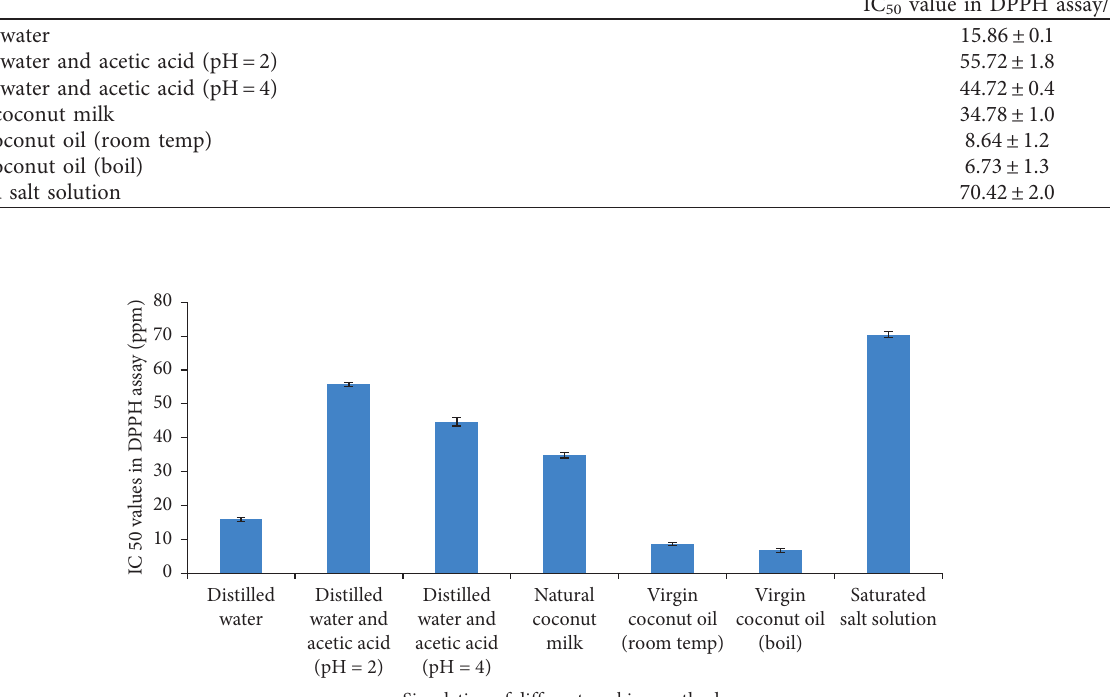
Table 1: IC 50 values of differently processed extracts of G. quaesita simulating cooking conditions in DPPH assay. Extract IC 50 value in DPPH assay/ppm Distilled water